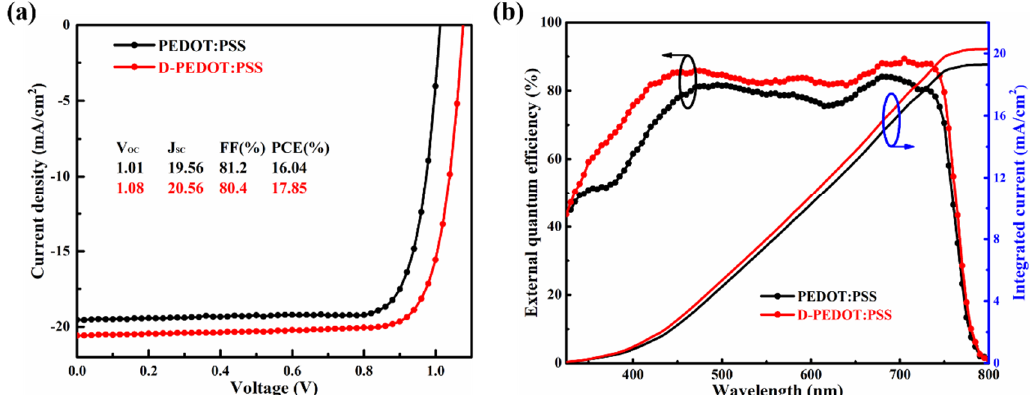
Figure 2. Photovoltaic performance of the optimal devices: ( a ) J−V curves; ( b ) EQE spectrum and integral current.